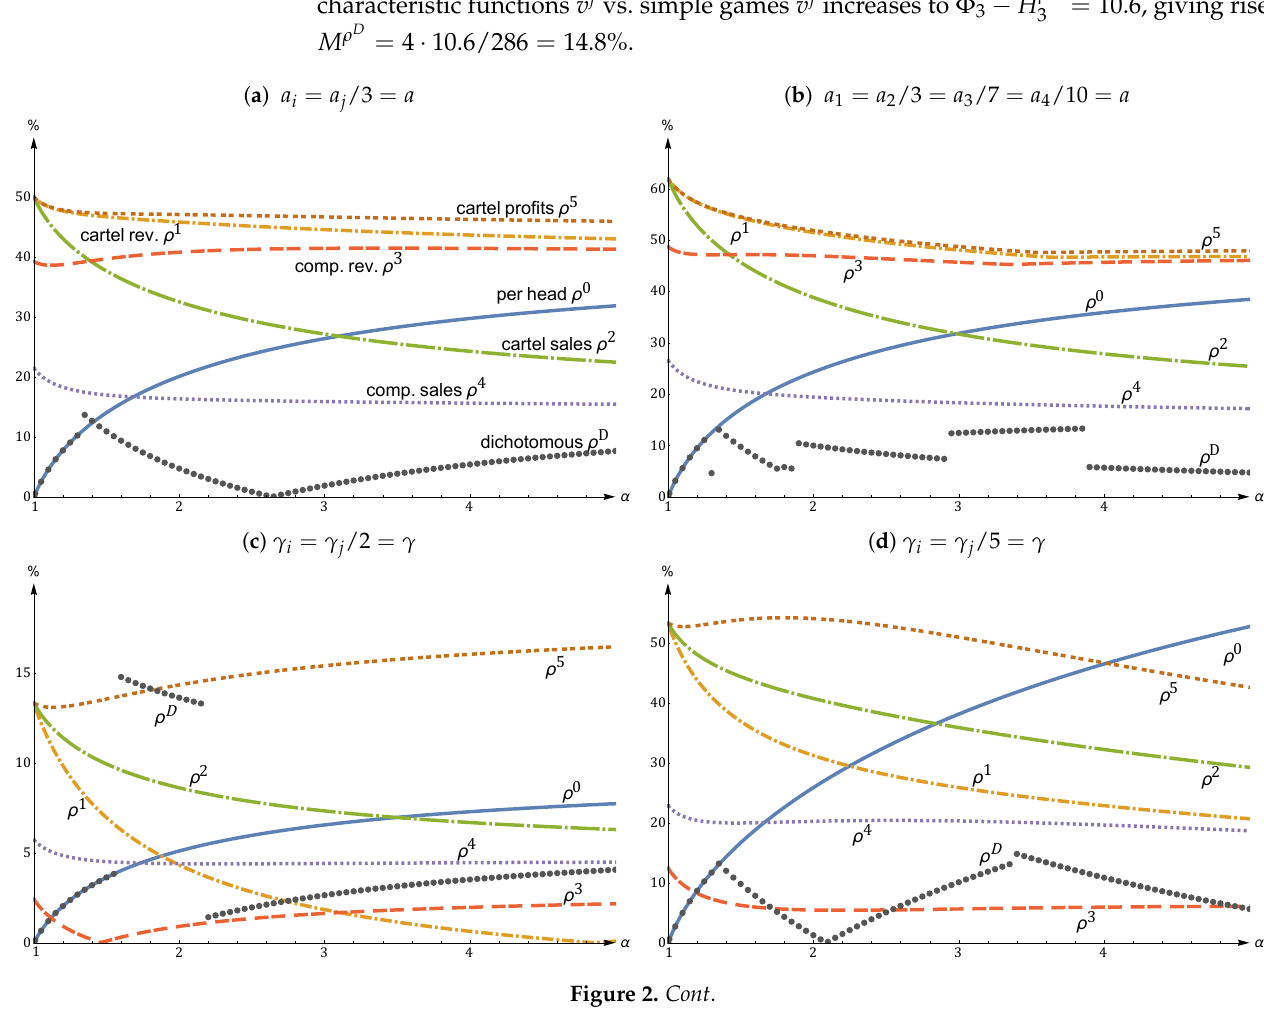
1 Figure 2. Cont